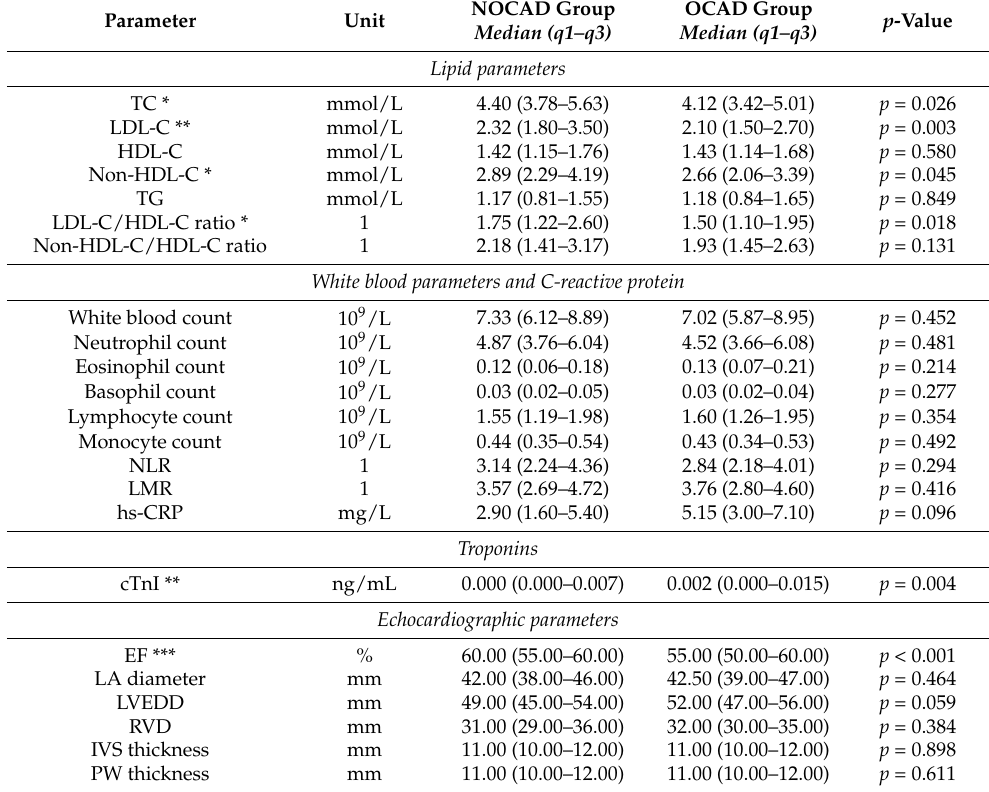
Table 2. Laboratory and echocardiographic